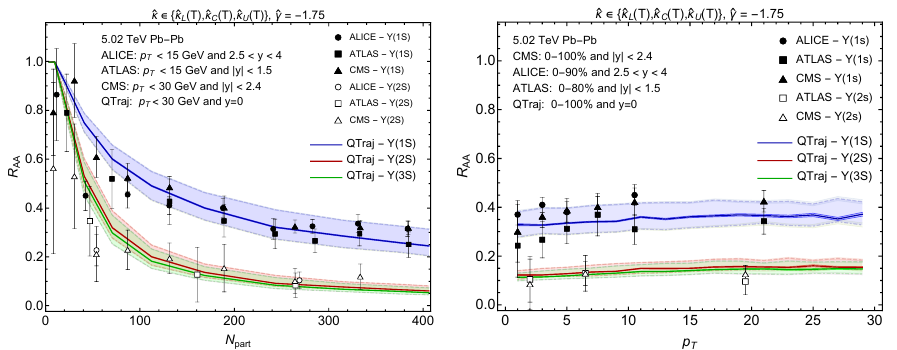
Figure 1. The nuclear modification factor R AA of the Υ (1 S ), Υ (2 S ), and Υ (3 S ) as a function of N part compared to experimental measurements from the ALICE [23], ATLAS [24], and CMS [25] collabora- tions. The bands indicate variation with respect to ˆ κ ( T ) (left) and ˆ γ (right). The central curves represent the central values of ˆ κ ( T ) and ˆ γ , and the dashed and dot-dashed lines represent the lower and upper values, respectively, of ˆ κ ( T ) and ˆ γ